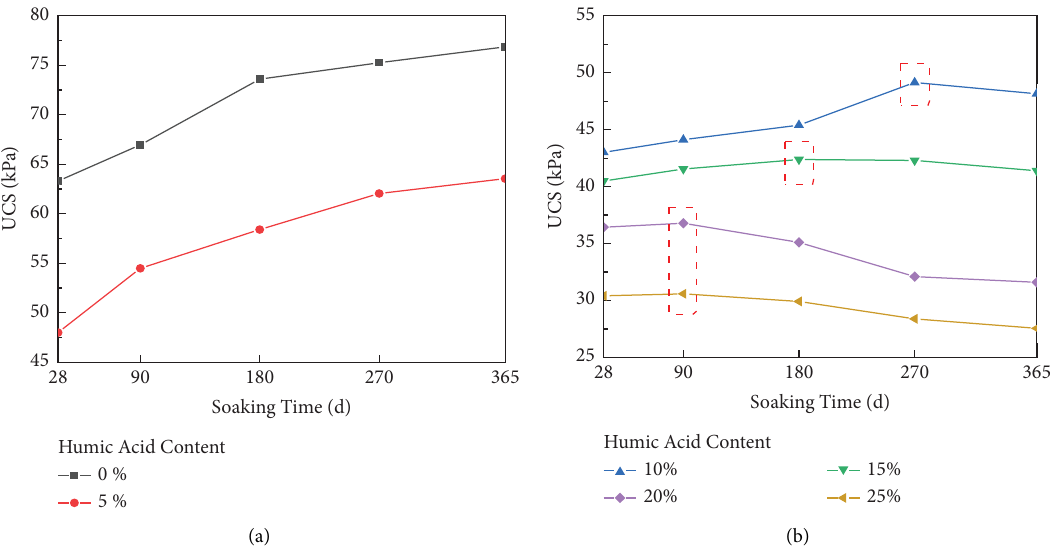
Figure 9: Relationship curve between sample UCS and soaking age (pH value of FA solution: